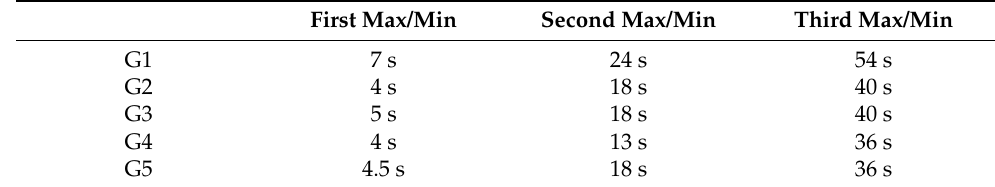
Table 3. Time to reach maximum/minimum tilting of the gear tooth for all geometry types. First Max/Min Second Max/Min